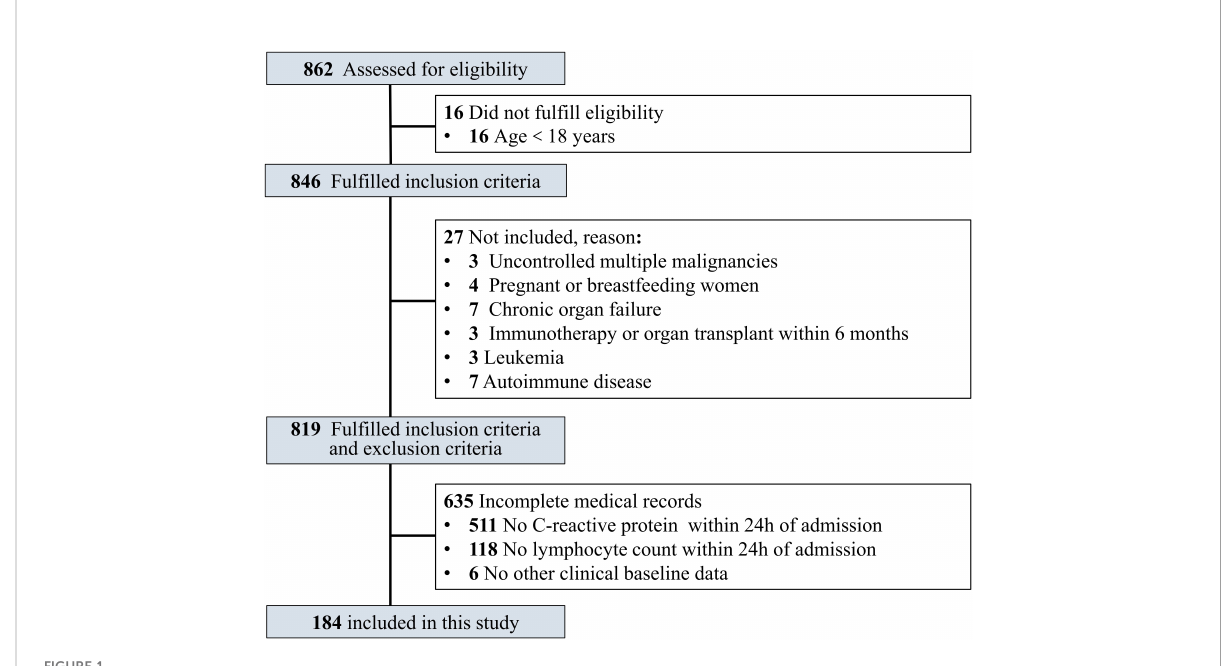
FIGURE 1 Flowchart of the study